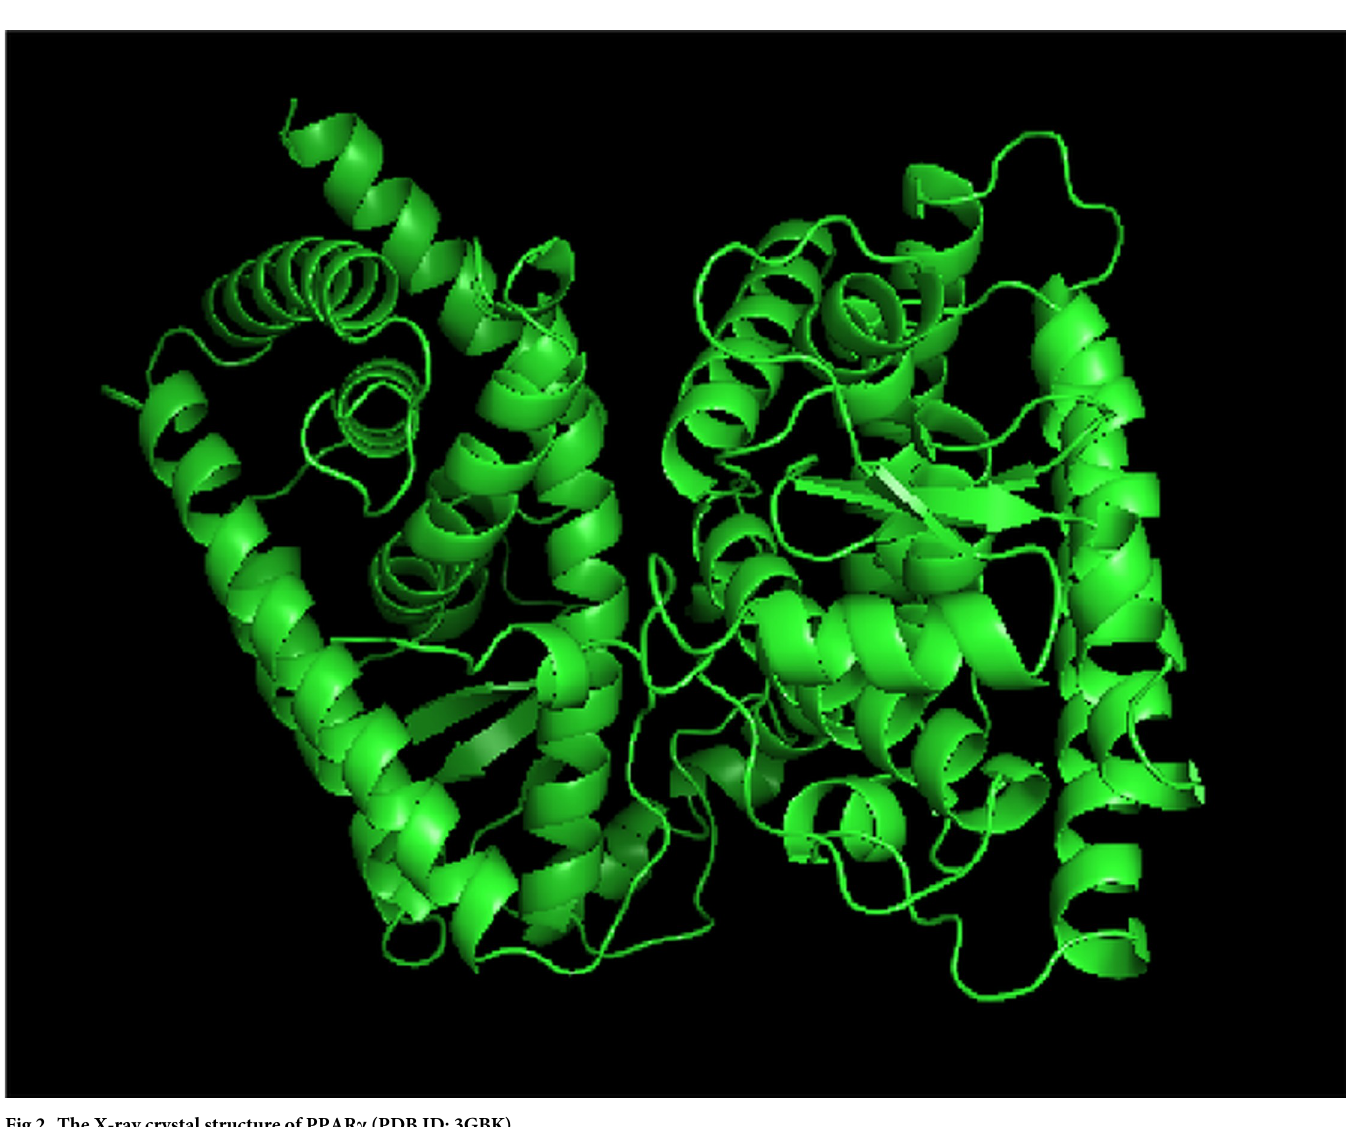
Fig 2. The X-ray crystal structure of PPAR γ (PDB ID: